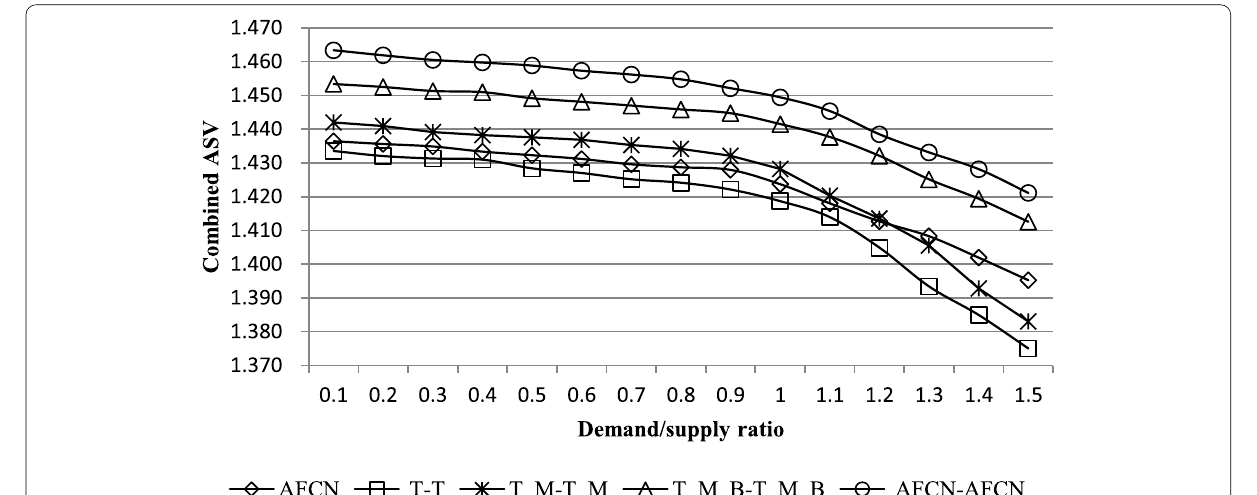
Fig. 8 Average combined ASV for different negotiation